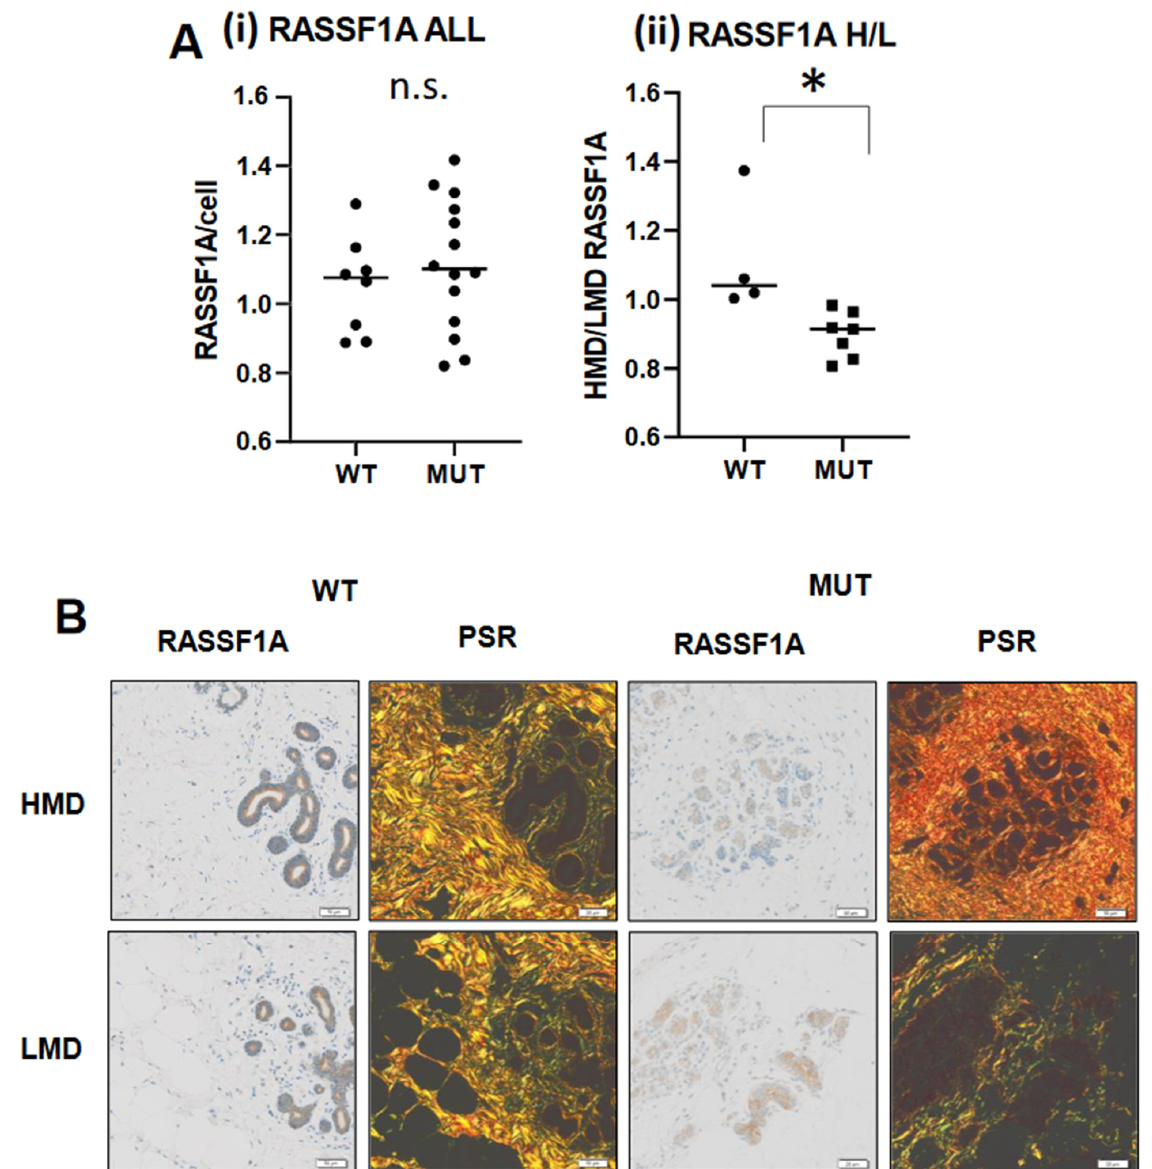
Figure 5. MD influences RASSF1A protein expression in BRCA1/2 gene mutated tissues. ( A ). RASSF1A protein expression per cell in WT versus BRCA mutated tissues (MUT) (i) not separated according to MD; (ii) expression of data in (i) presented as an HMD/LMD index (H/L). Student’s paired t test was used to determine significance, where * denotes p < 0.05. The Shapiro–Wilk test was performed prior, to ascertain normality. n.s. denotes no significance. ( B ). Representative images of HMD versus LMD in WT versus MUT for RASSF1A and their accompanying PSR images, 10 × magnification, scale bar = 50